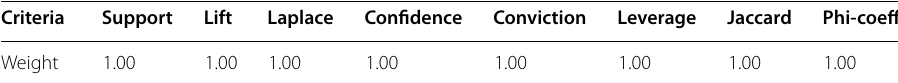
Table 8 Weights of relative importance Criteria Support Lift Laplace Confidence Conviction Leverage